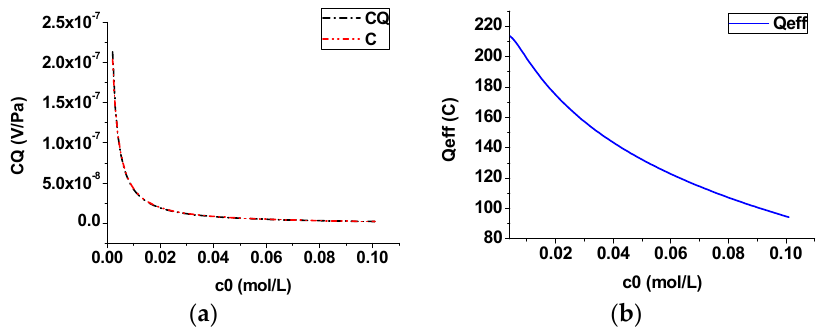
Figure 5. Effect of the salinity (steady case): ( a ) streaming potential coupling coefficient; ( b ) effective net residual charge density.